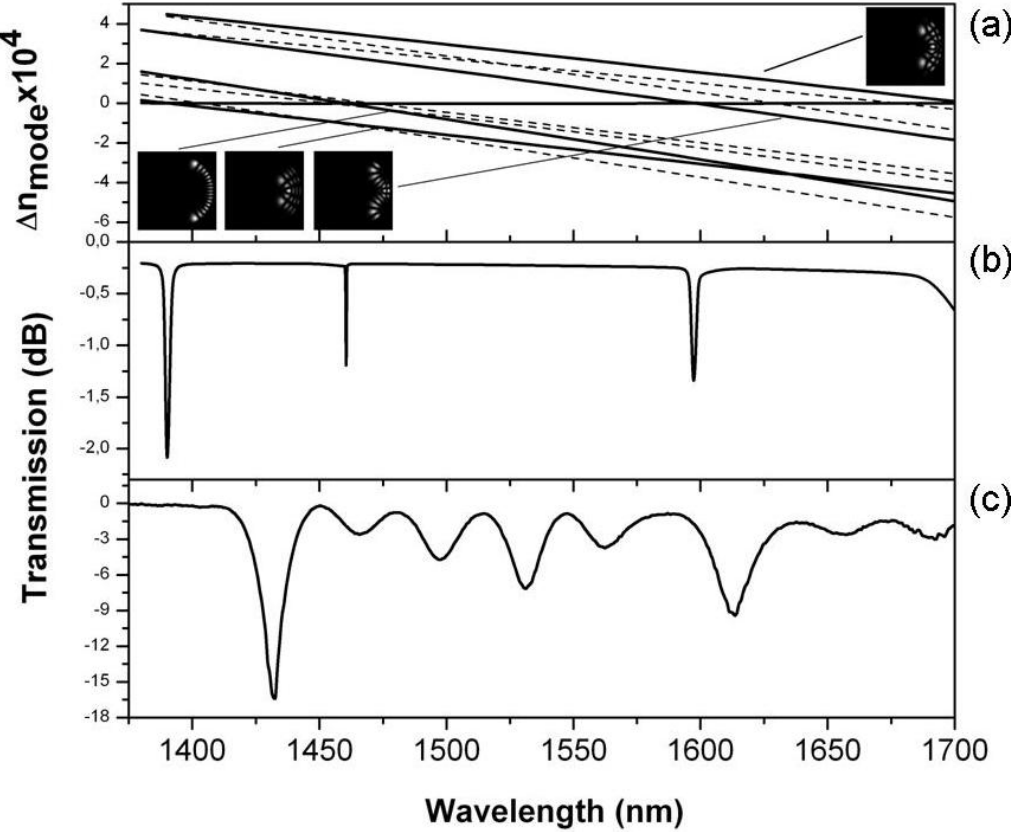
Figure 3. ( a ) High order mode index difference with respect the fundamental mode index with κ = 0: coupled modes with anti-crossing curves (solid lines), and non coupled modes (dashed lines). The insets show the mode intensity patterns of the coupled modes in a box of 133 × 133 μm. ( b ) Theoretical transmission spectrum. ( c ) Experimental